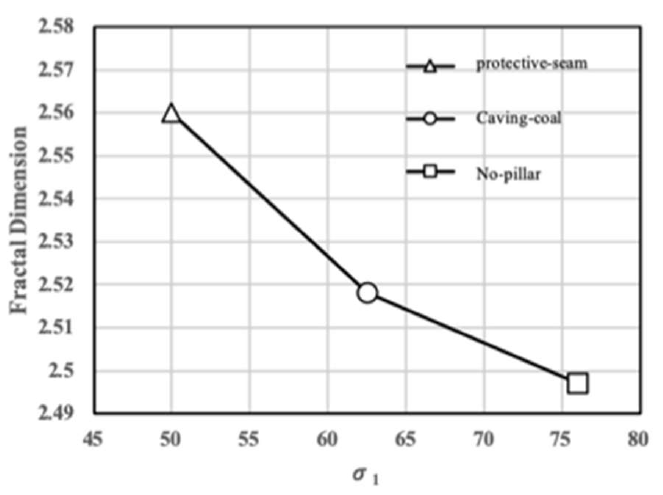
Figure 9. Relationship between AE spatial fractal dimension and stress under different mining conditions.